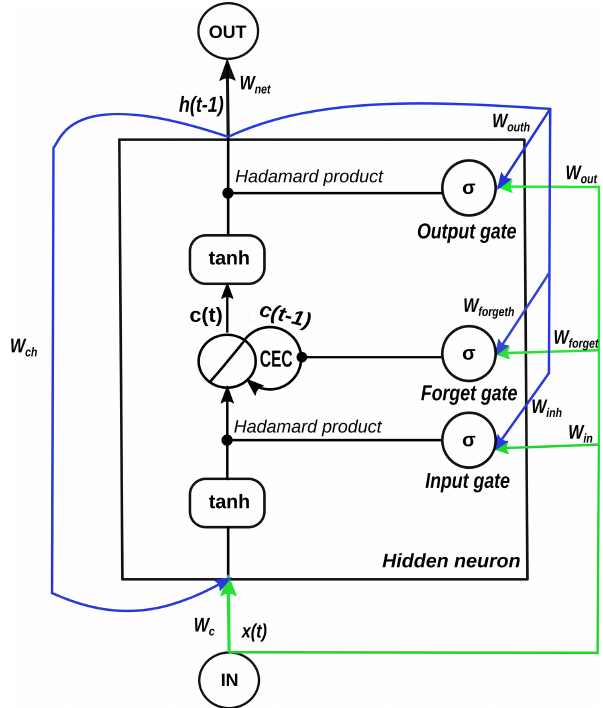
Figure 2. One hidden layer LSTM network with one hidden neu- ron. The green lines indicate the entry points of new inputs into the hidden neuron. The blue lines show the entry points of previous out- puts into the hidden neuron, where w ∗ is the weight on a linkage, h( ∗ ) is the output of the hidden neuron, x(t) is the input at the time step t , and c( ∗ ) is the cell state of the constant error carousel (CEC). σ represents a sigmoid function of a gate, and tanh is a hyperbolic tangent